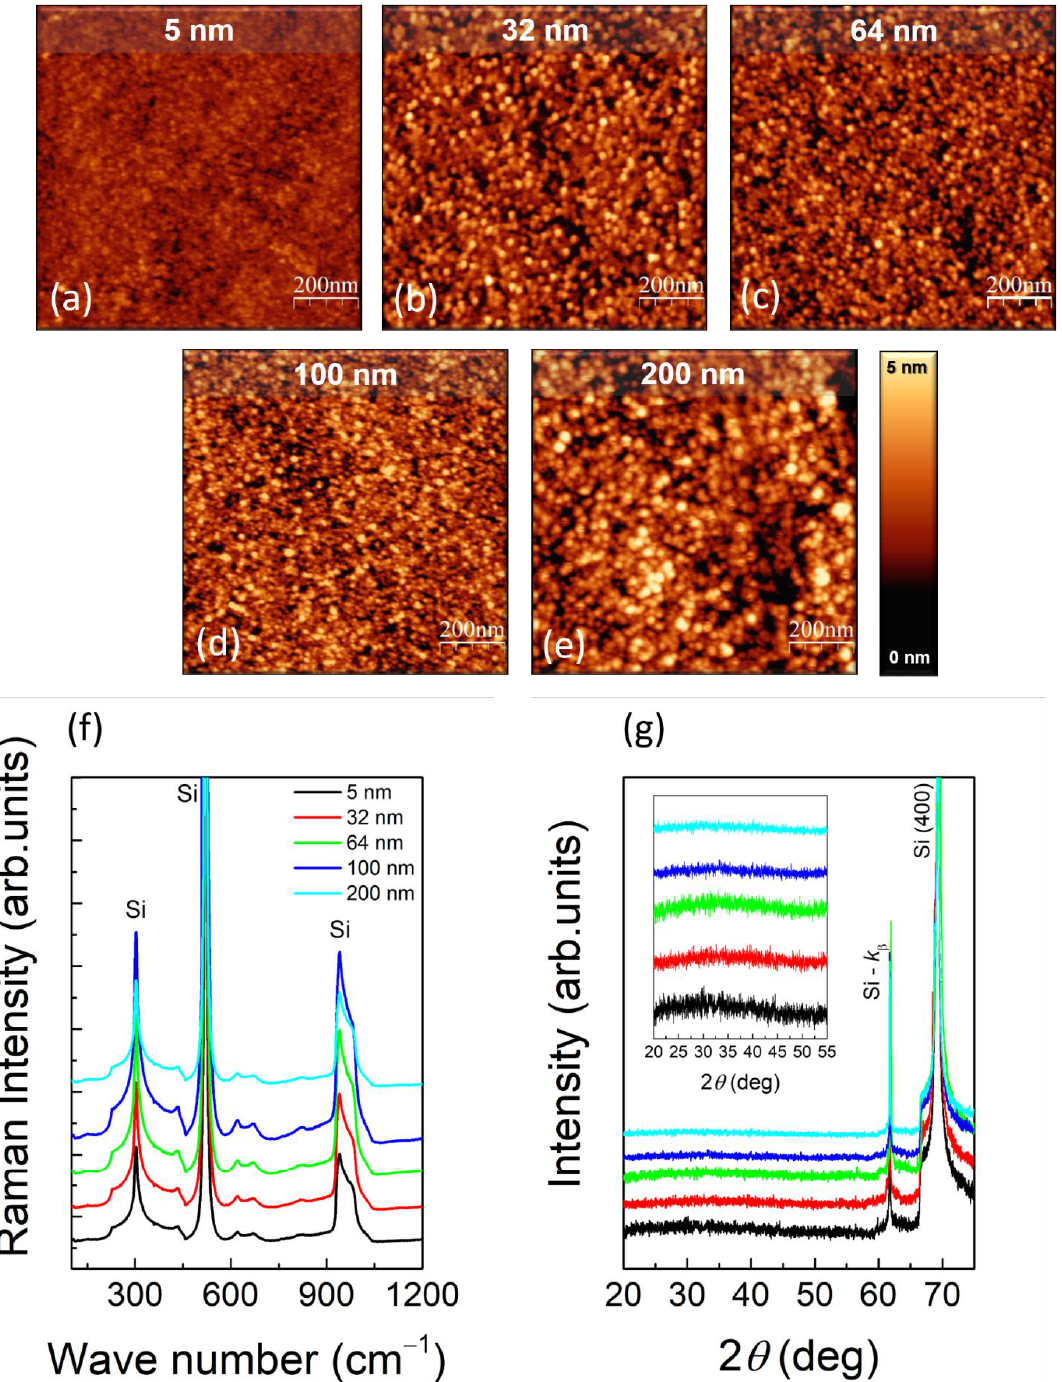
Figure 1. ( a – e ) Tapping-mode AFM topography, 1 µ m × 1 µ m in size, of as-grown TiO 2 samples; ( f ) RS spectra— wavenumber range from 100 to 1200 cm − 1 ; ( g ) XRD spectra—2 θ range from 20 to 75 ◦ (main) and from 20 to 55 ◦ (inset). Black, red, green, blue, and cyan curves refer to 5, 32, 64, 100, and 200 nm. The curves have been offset along the y -axis for better